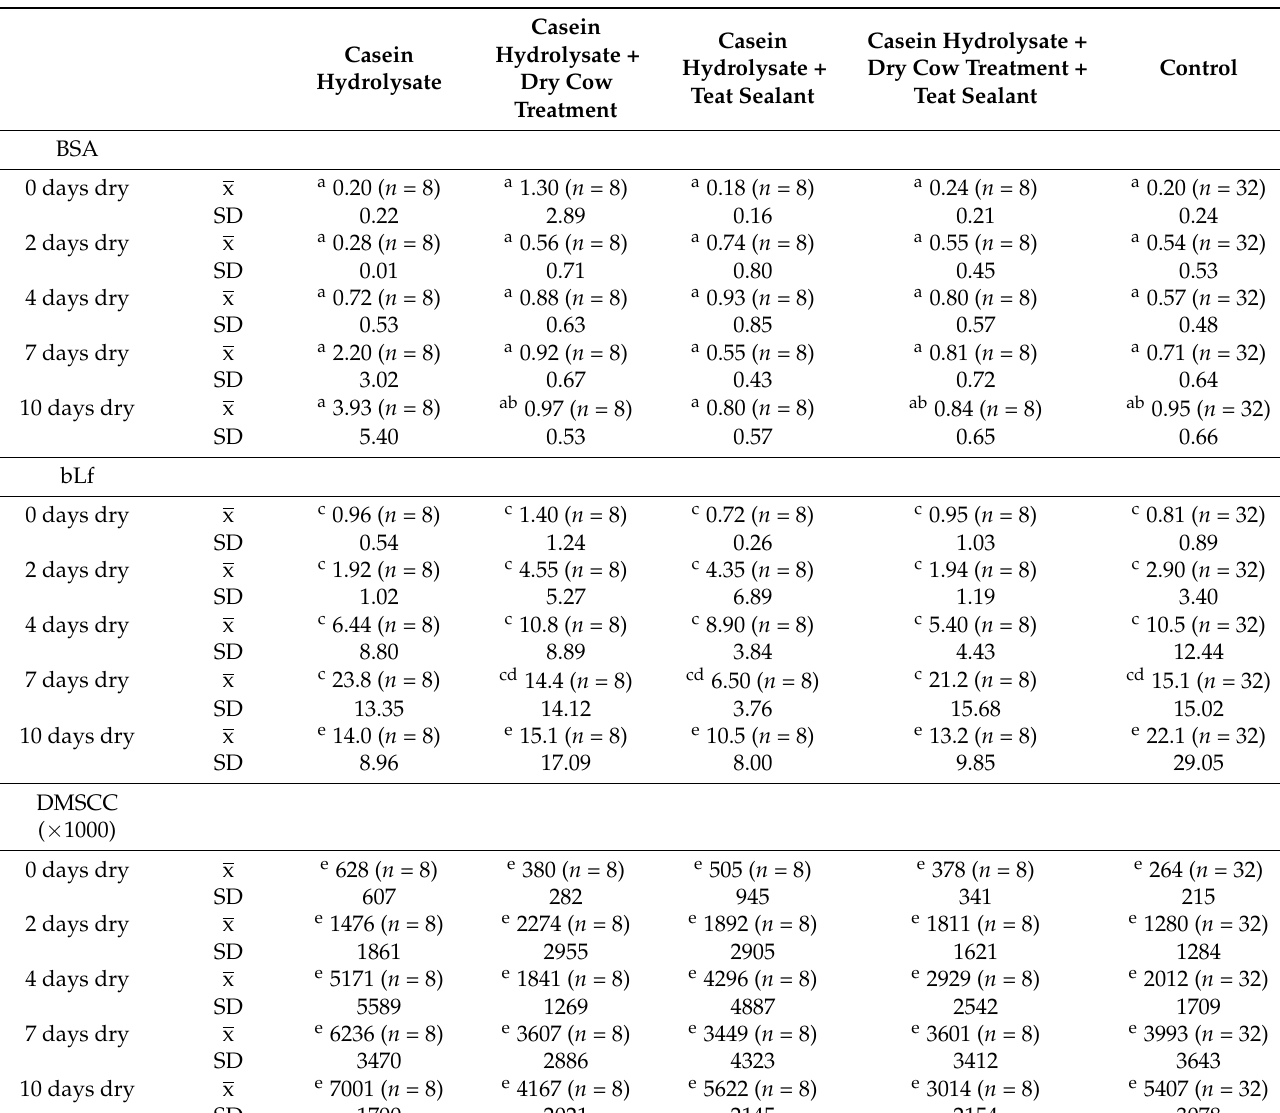
Table 3. Means of milk concentrations (mg/mL) of indicators of mammary involution by days dry and treatment group.